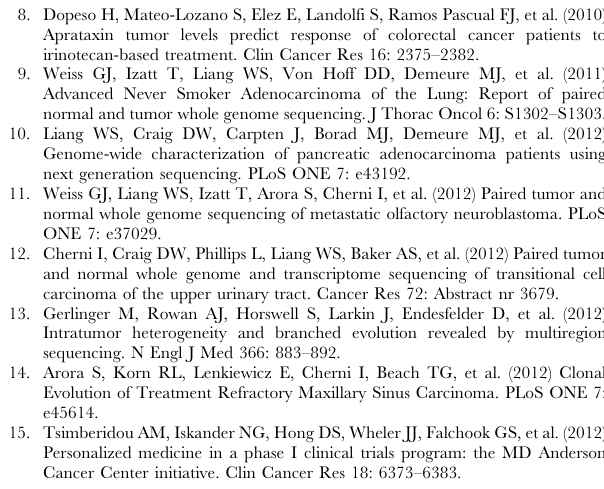
Figure S1 Patient 9 WTS data canonical maps. This figure illustrates the top 20 canonical maps enriched in the WTS data for patient 9. Figure S2 Role of stellate cells in progression of pancreatic cancer. This figure illustrates the role of stellate cells in pancreatic cancer progression. Figure S3 Development Regulation of epithelial to mesenchymal transition. This figure illustrates the possible involvement of TGF-beta mediated epithelial to mesenchymal transition. Figure S4 Selected canonical map for Patient 10: Cell cycle spindle assembly and chromosome separation. This figure illustrates cell cycle spindle assembly and chromosome separation, including the upregulated and druggable target, aurora-B (AURKB). Figure S5 Selected canonical map for Patient 10: EGF- and HGF-dependent stimulation of metastasis in gastric cancer. This figure illustrates EGF- and HGF-dependent stimulation in gastric cancer metastasis. Alpha-6/beta-4 integrin components are upregulated and function in concert with MET to activate downstream signal transduction.